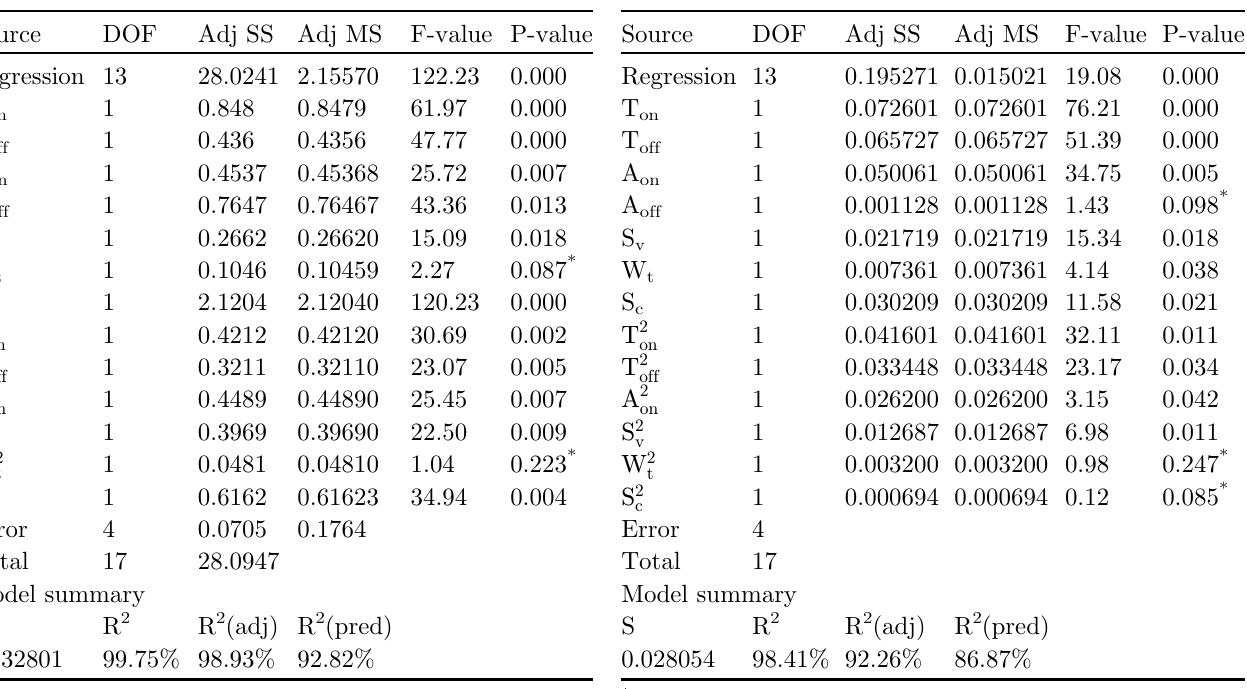
Table 3. ANOVA for cutting speed.